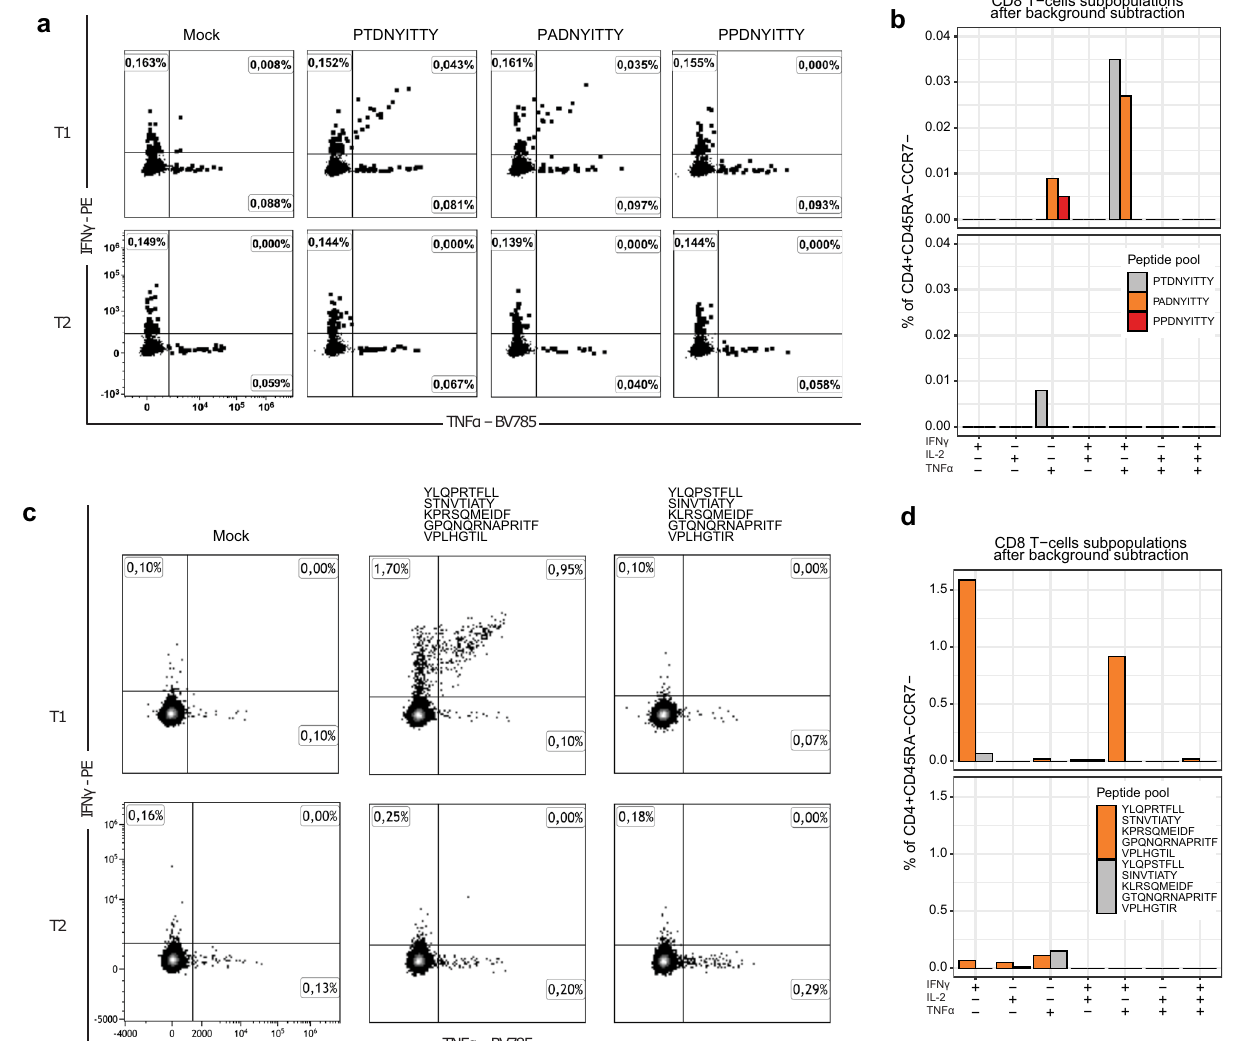
Fig. 3 | The CD8 T cell immune response to the SARS-CoV-2 epitopes in ancestral and derived states. a , c Flow cytometry plots showing the cytokine pro fi les of SARS-CoV-2-speci fi c CD8 effector memoryT cells after stimulation with epitopes carrying the ancestral and the two derived (nsp3:T504A and nsp3:T504P) amino acid variants c , and pools of 5 immunogenic HLA binders before and after acquiring the binder-escape mutations. Amino acid variants corresponding to